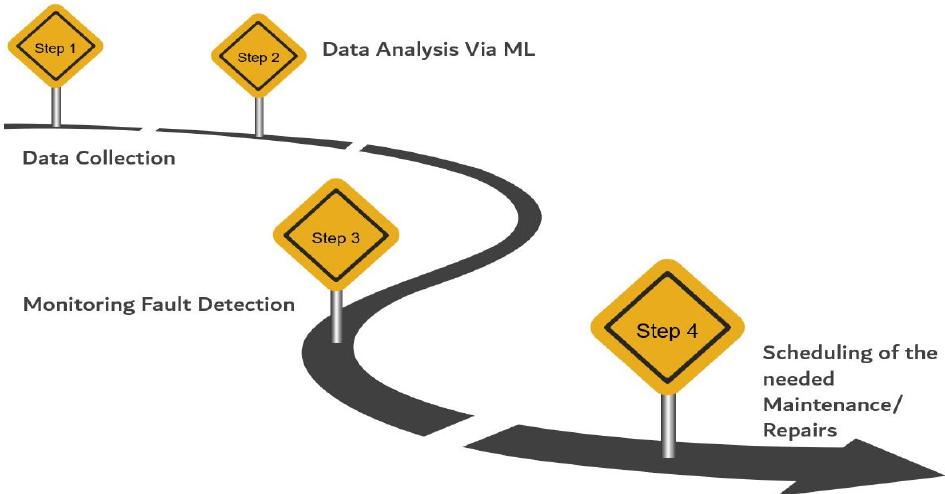
Figure 1. PdM 4.0 Route.